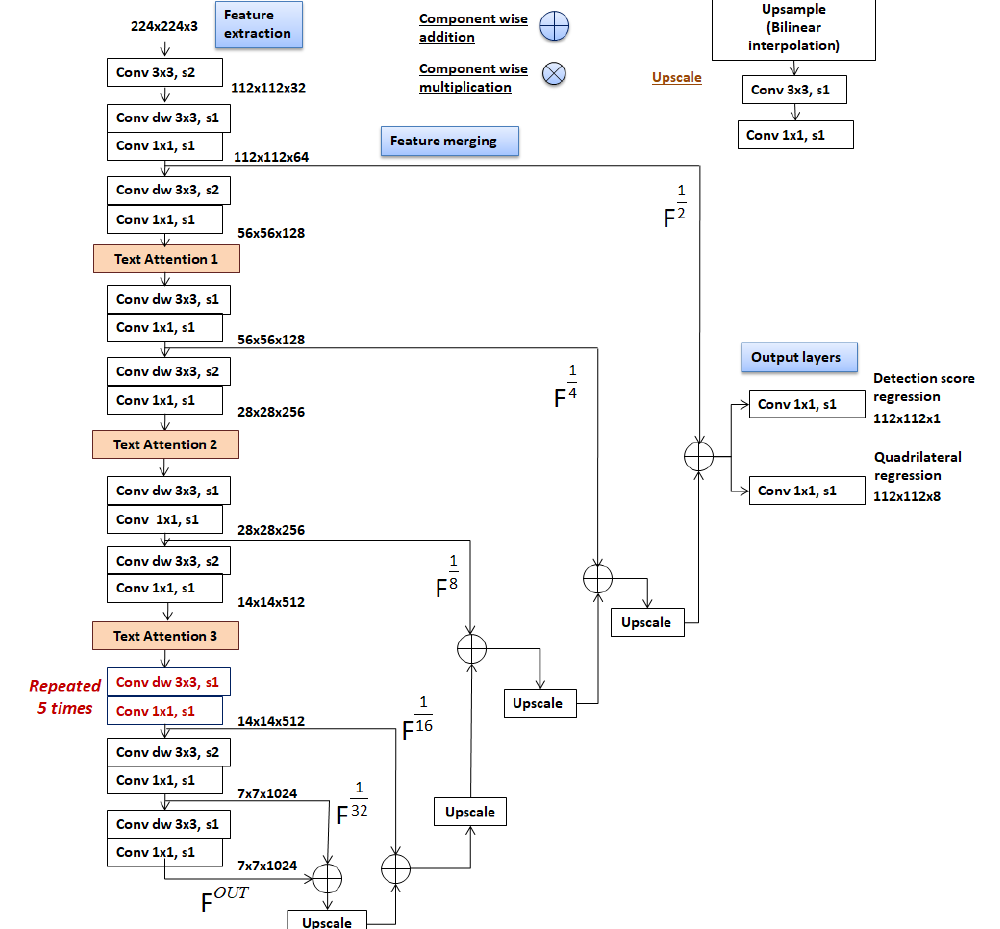
Figure 1. MobileTDNet scene text detection